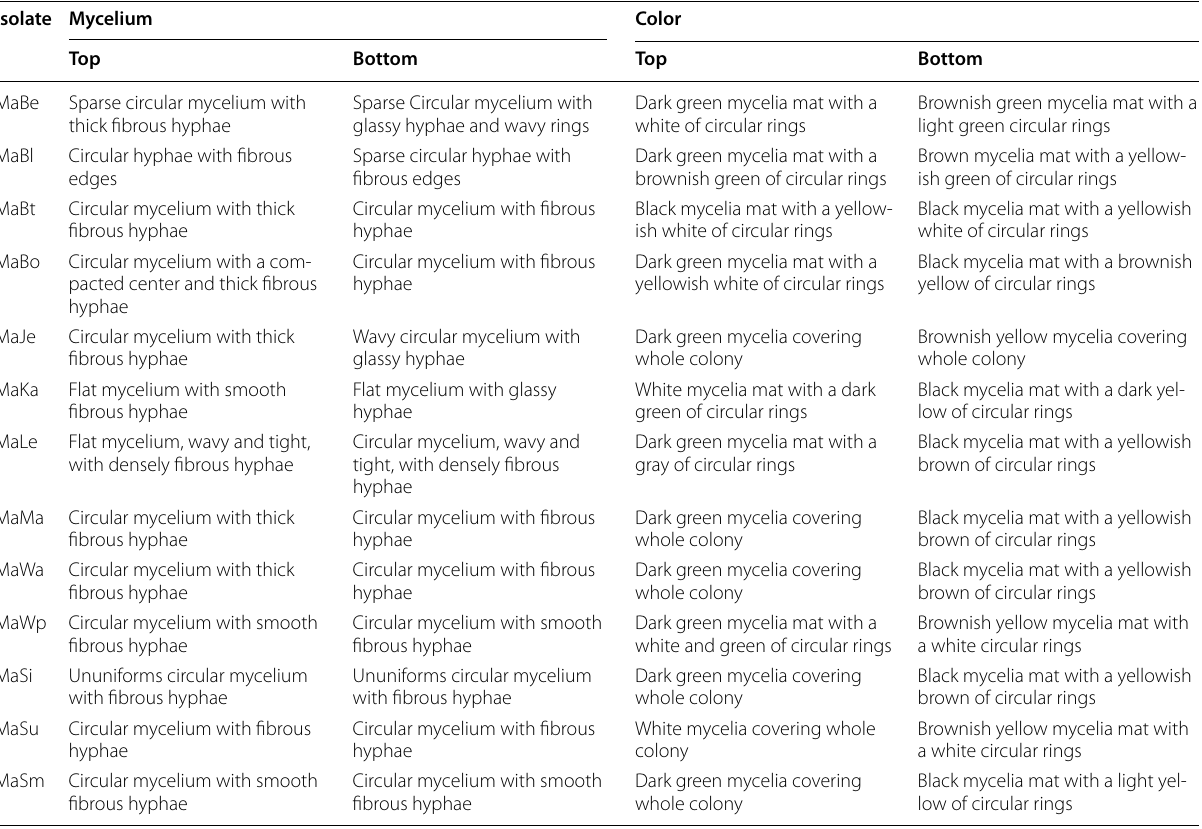
Table 2 Cultural characteristics of 13 Metarhizium isolates cultured in potato dextrose agar Isolate Mycelium Color Bottom Top